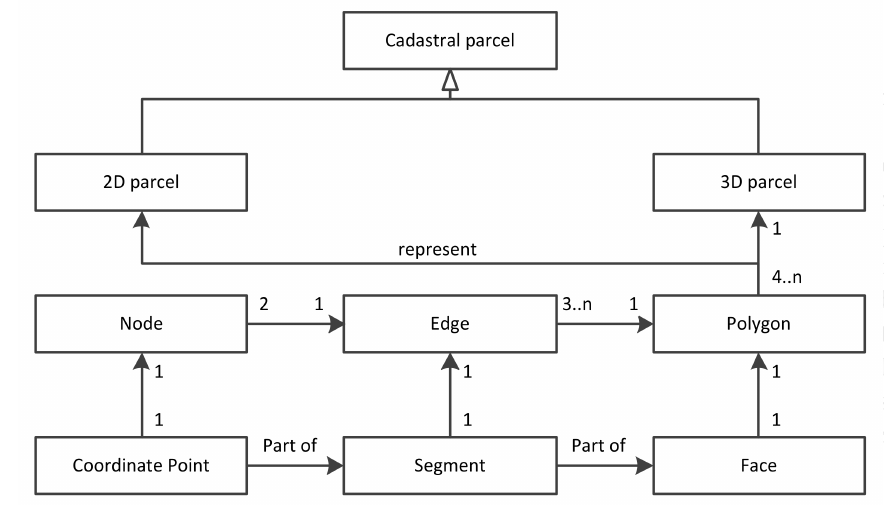
Figure 1. Geometrical and topological structure for cadastral parcel in a 3-D